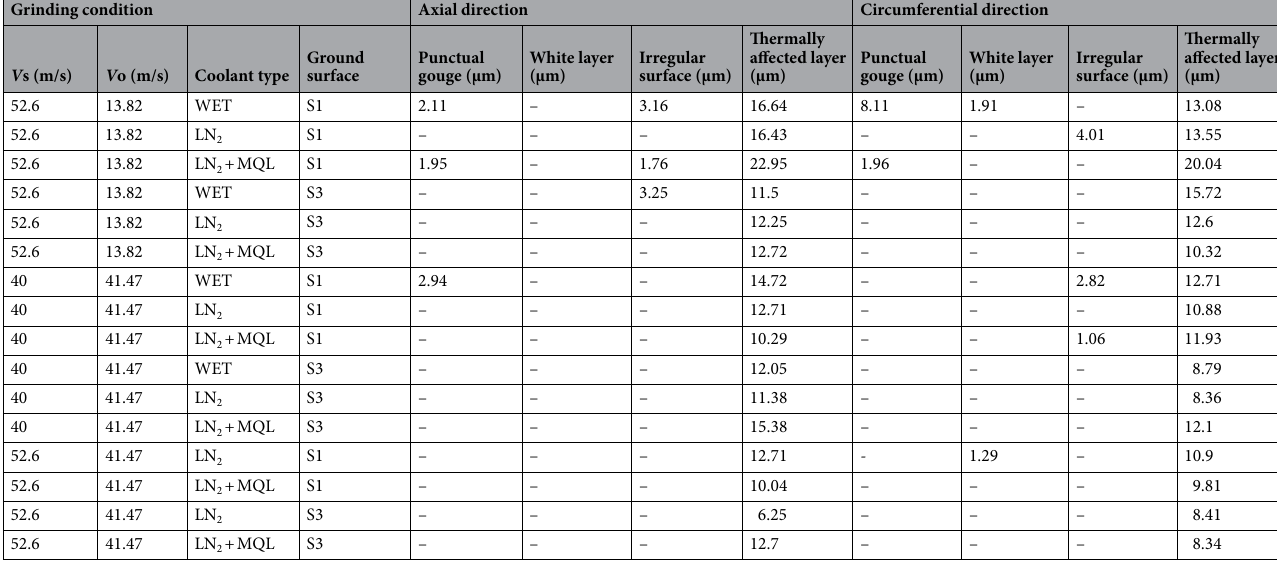
Table 4. Maximum size of microstructural defects. (Empty spaces indicate that the type of defect was not found in that grinding